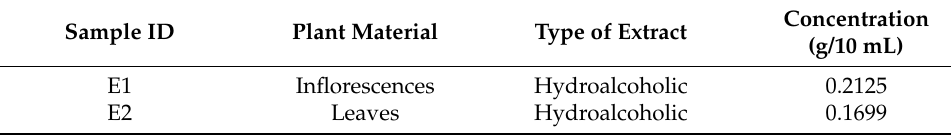
Table 1. Cannabis sativa L. cultivar strawberry